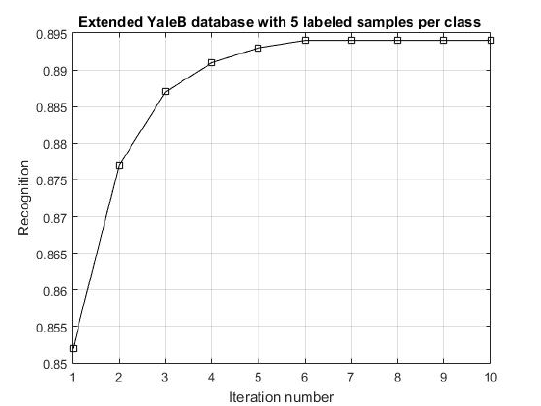
Fig. 2 Recognition rate versus iteration number for the Extended YaleB database with five labeled training samples per